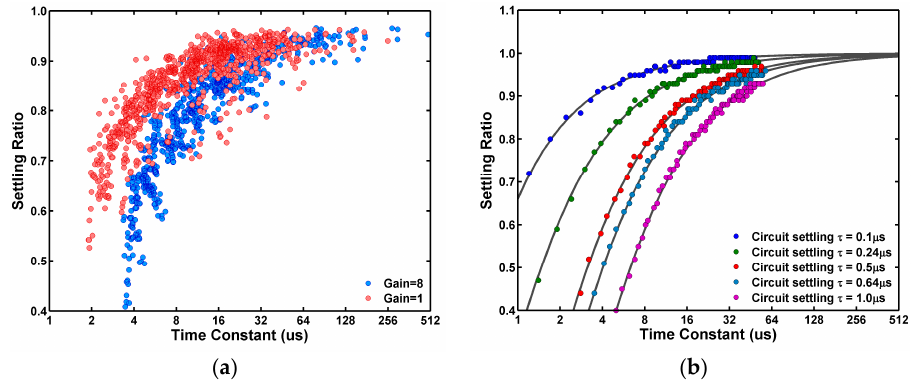
Figure 17. ( a ) The measured 3-peak pixels settling ratios versus the RTN time constants for the cases 1X and 8X gains. At 1X gain the settling ratios are higher than those at 8X gain because of the circuit settling time at 1X gain is shorter than that at 8X gain; ( b ) The MATLAB RTN behavior simulation results approximately reproduce the observed trends in the measured